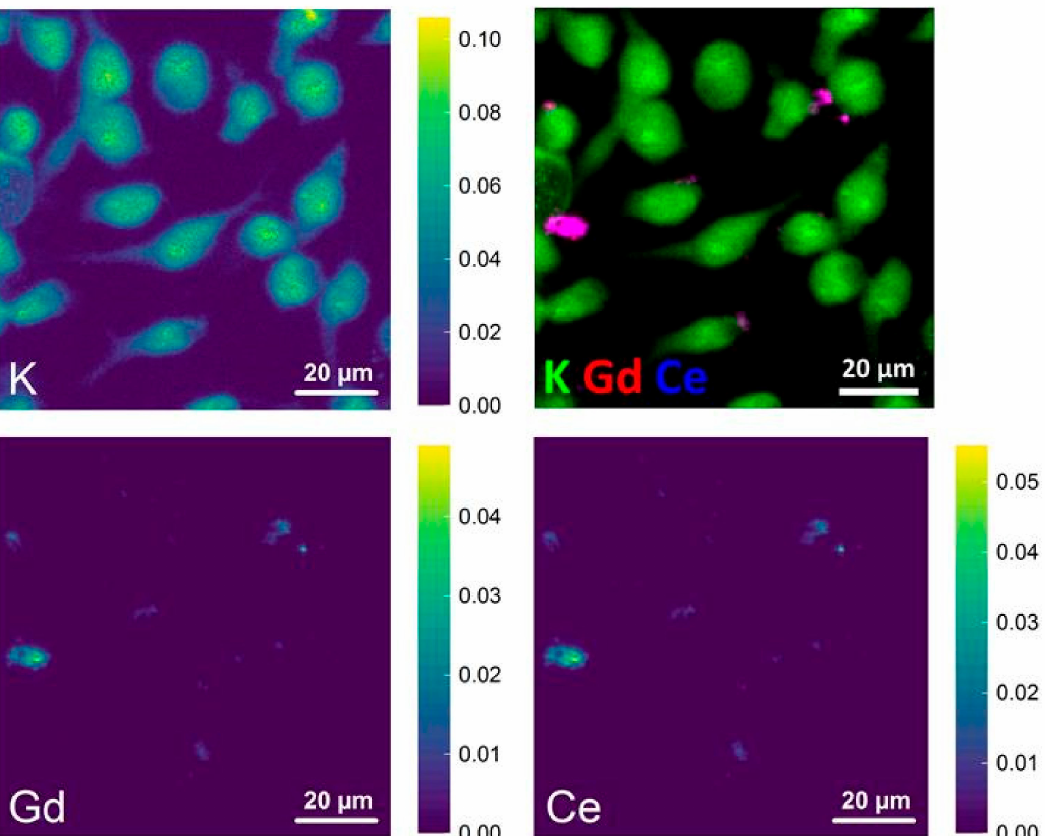
Figure 9. Single-element XRF maps (100 µ m × 100 µ m) of cells exposed to GdCeO 2 S (50% Ce) nanoparticles showing distribution of K ( top left ), Gd ( bottom left ) and Ce ( bottom right ). The images are displayed using a linear scale. The values in the color bars represent the concentration of elements in mM. The XRF maps were acquired at 7.4 keV. The merge color-coded map is also presented ( top right